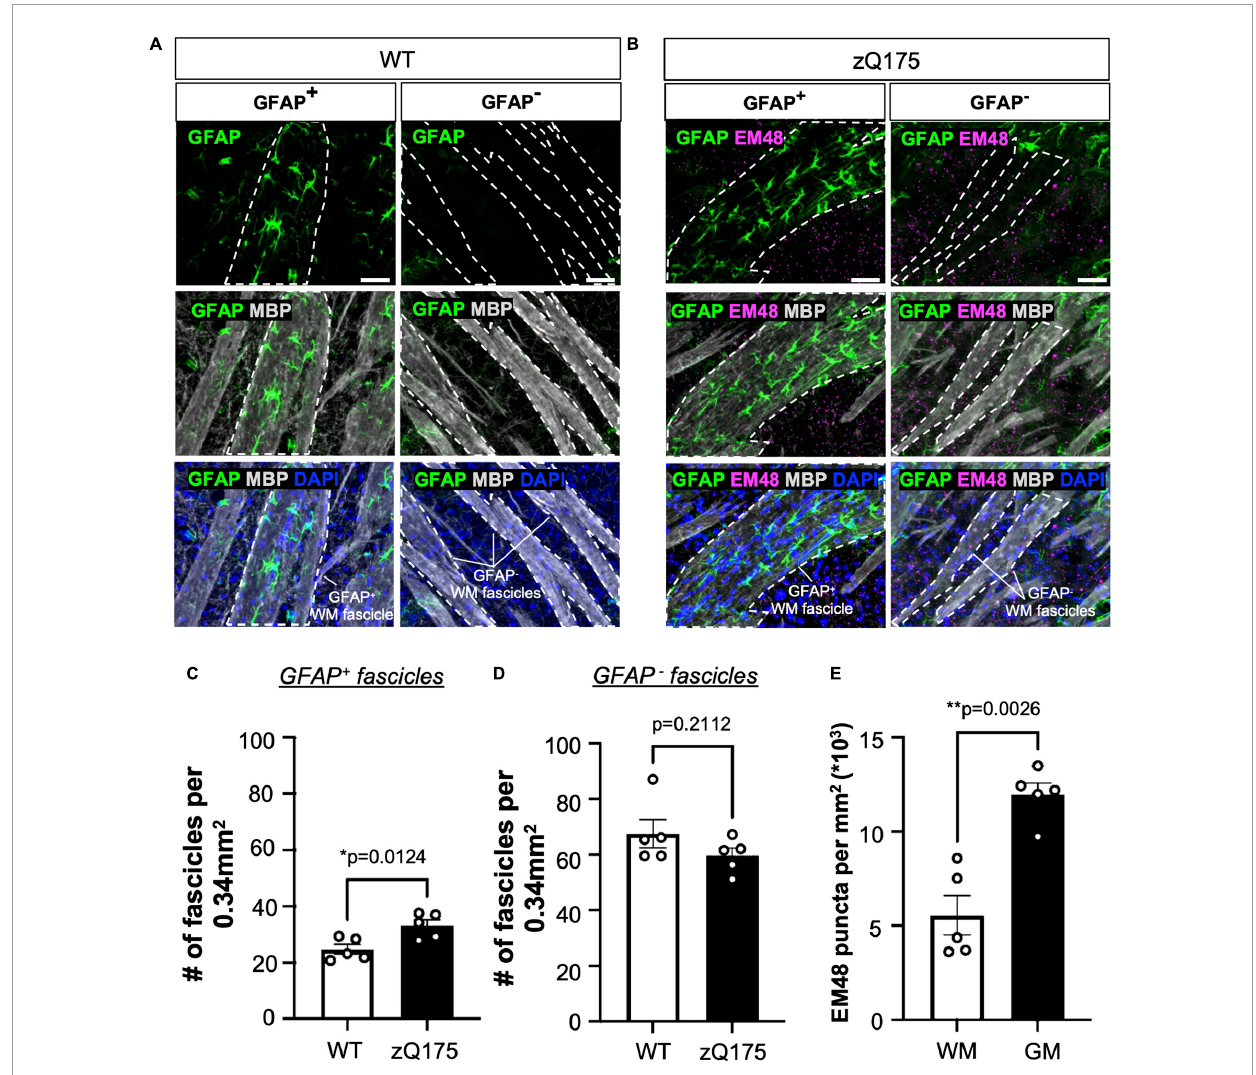
FIGURE6 White matter (WM) fascicles are associated with areas of low aggregate load. GFAP and EM48 immunofluorescence on sagittal sections from 18-month-old WT (A) and zQ175 (B) mice. Scale bar is 50 µ m. Number of GFAP + (C) and GFAP − (D) fascicles per 0.34 mm 2 in whole striatum of 18-month-old WT and zQ175 mice ( n = 5 mice/genotype). (E) Number of EM48 puncta per mm 2 inside WM fascicles and in gray matter (GM) in 18-month-old zQ175 mice ( n = 5 mice/genotype). All analysis was done using confocal images. Paired [ (E) t = 6.701, df = 4] and un-paired [ (C) t = 3.212, df = 8; (D) t = 1.359, df = 8] student’s t -tests. Error bars denote mean ± SEM. * p < 0.05, ** p <